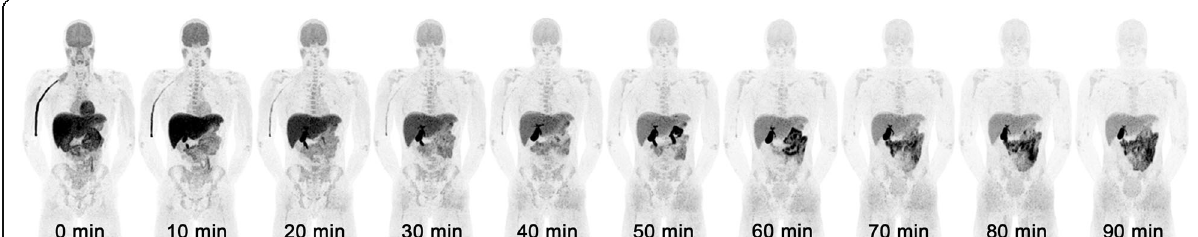
Fig. 2 Maximum-intensity projection PET images of the sequential whole body PET-scans from 0 to 90 min after injection of [ 18 F]-PSS232 in the right cubital vein. All images are displayed with the same intensity scale